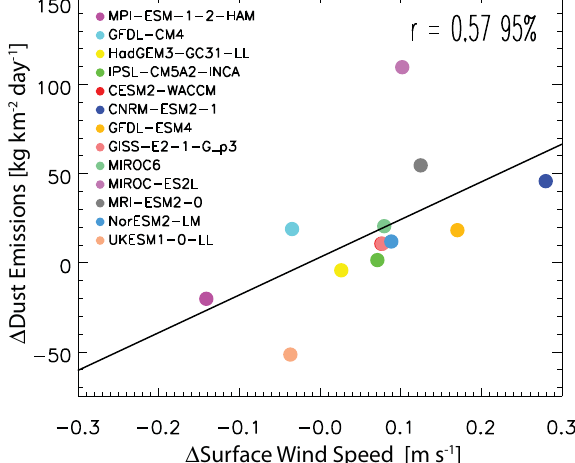
Fig. 4 Change in dust emissions versus the change in surface wind speed over northern Africa in individual models. Scatter plot of the change in dust emissions [kg km − 2 day − 1 ] versus the change in surface wind speed [m s − 1 ] over northern Africa for each model (color coded as de fi ned in the legend). Black line shows the least squares regression slope. The correlation coef fi cient ( r ) is 0.57, signi fi cant at the 95% con fi dence